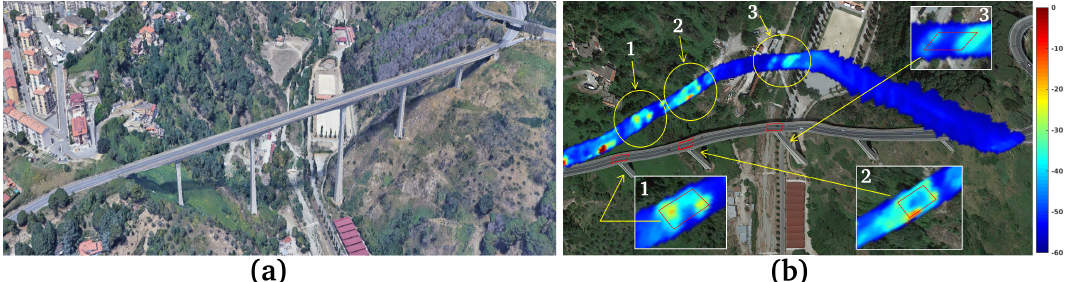
Figure 22. ( a ) Optical representation of the “Italia” bridge, ( b ) vibration map of the “Italia” bridge.